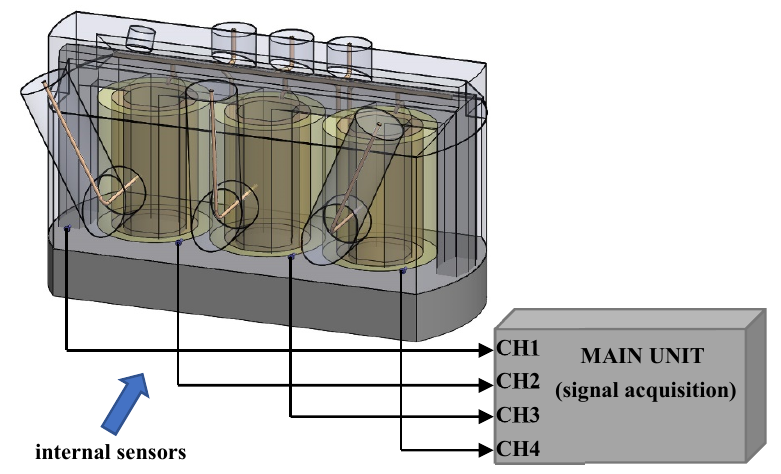
Figure 18. Sensors configuration within the standard detection mode.